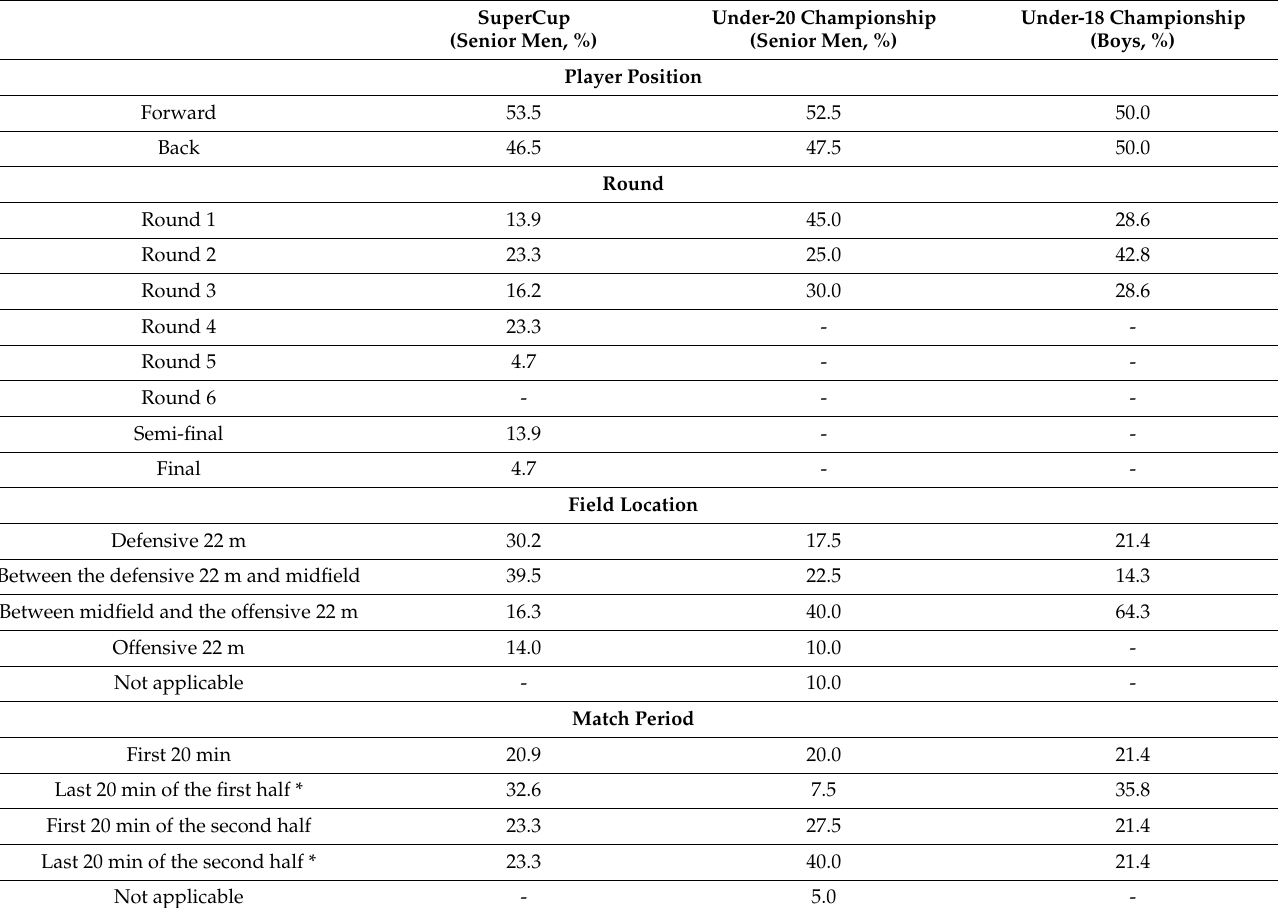
Table 3. Player’s position, round of the competition, field location, and time of injury in Rugby Europe